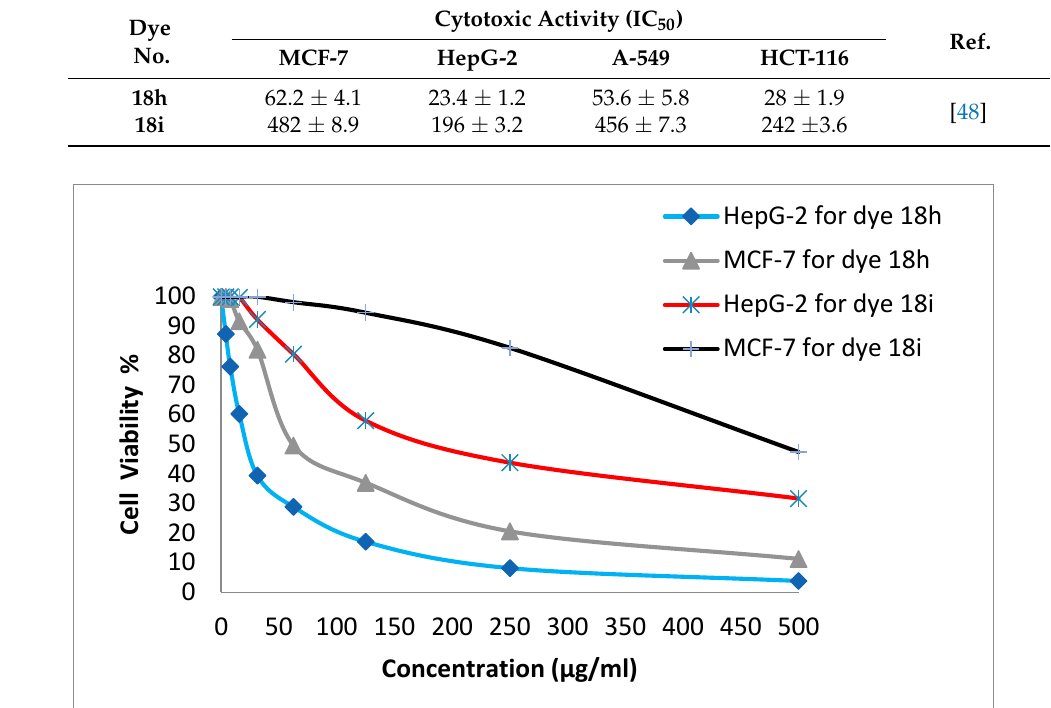
Figure 6. Antitumor (HepG-2) and (MCF-7) activities of disperse dyes 18h and 18i.